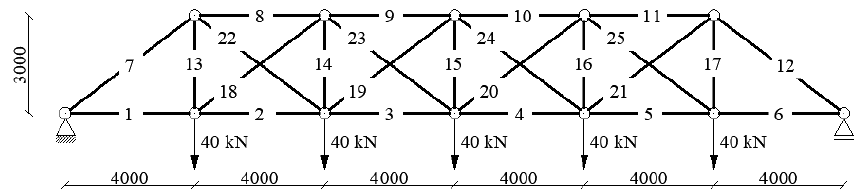
Figure 4. The static scheme of the analyzed truss.